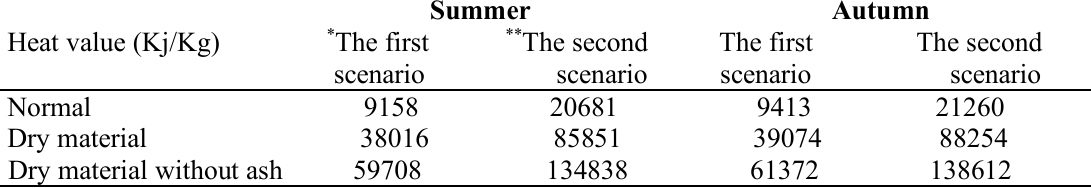
Table 3. Calculation of total heat value in two seasons Heat value (Kj/Kg)